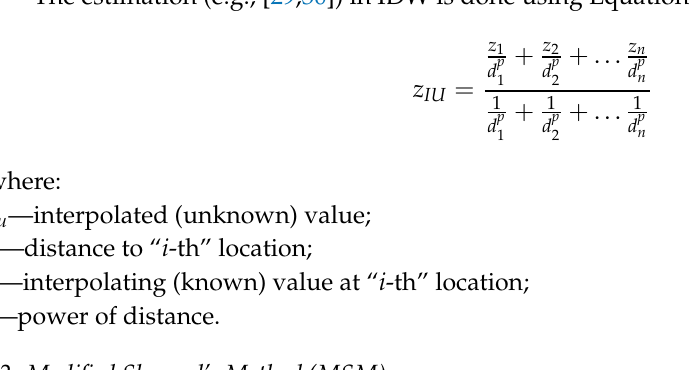
Figure 6. Points included within the IDW interpolation area (from [ 3 ]).